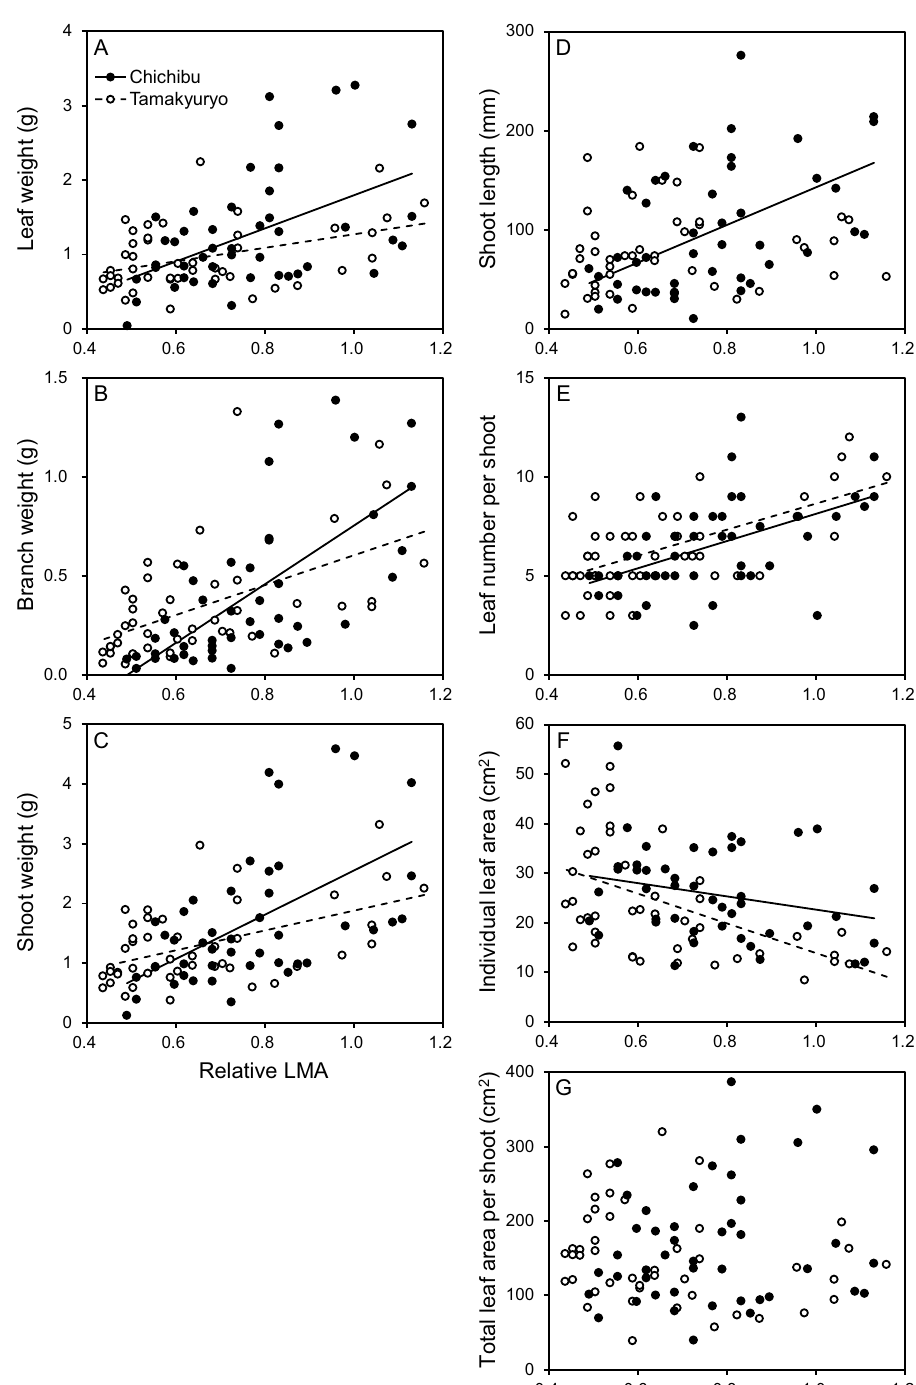
Figure 1. Dry mass of ( a ) leaf, ( b ) branch, ( c ) shoot, ( d ) shoot length, ( e ) leaf number per shoot, ( f ) individual leaf area, and ( g ) total leaf area per shoot as a function of relative LMA of Q. serrata grown in FM Tamakyuryo in July 2018 (while circle) and FM Chichibu in August 2018 (black circle) (n = 45). Dotted and solid lines indicate regression line of FM Tamakyuryo and FM Chichibu, respectively. Regression lines were drawn when there was a significant effect of relative